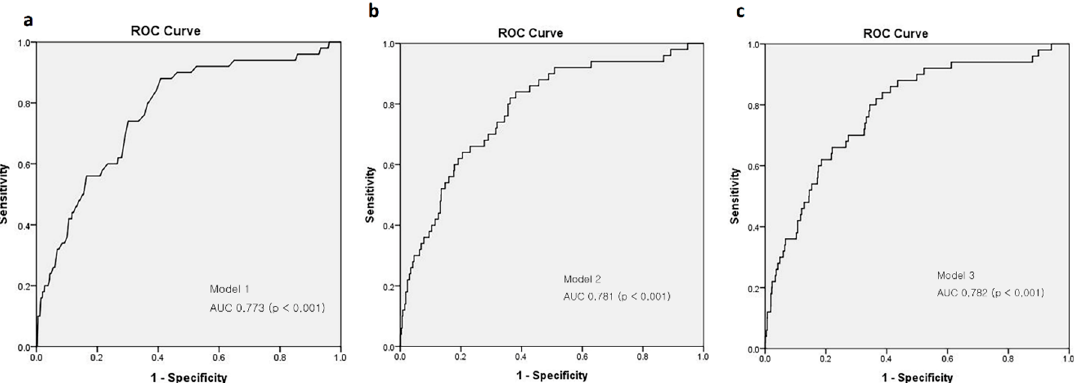
Figure 1. Receiver Operating Characteristic (ROC) curves for the multivariate logistic regression models. Model 1 ( a ) adjusted for age, sex, presence of proteinuria, model 2 ( b ) further adjustment for HbA1c and total cholesterol to model 1, model 3 ( c ) further adjustment for diastolic blood pressure, history of CVD, eGFR, and lipid lowering medication to model 2.